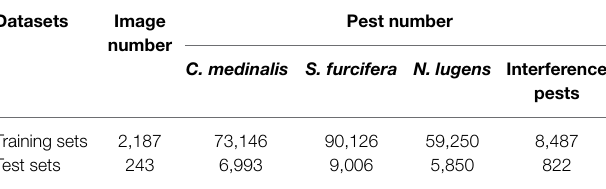
TABLE 1 | The number of migratory pests on